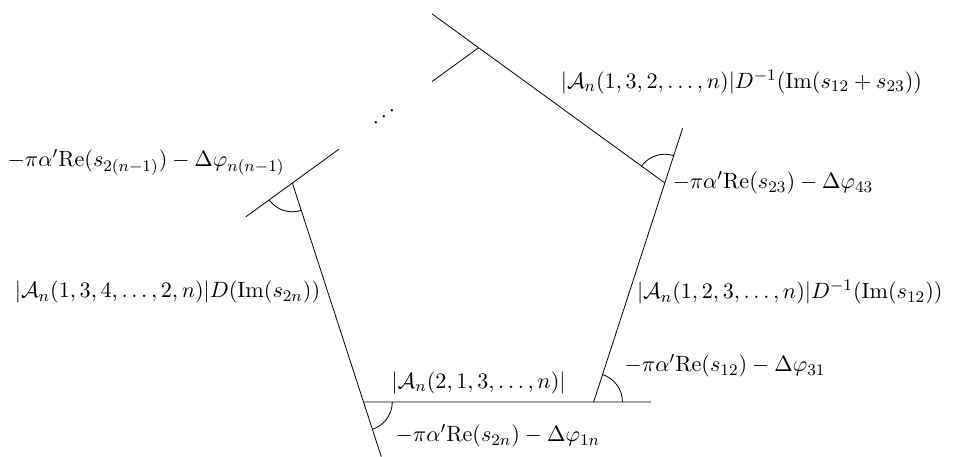
Figure 14. Plahte diagram for N -point open tachyon string amplitudes with complex momenta corresponding to the Plahte identity